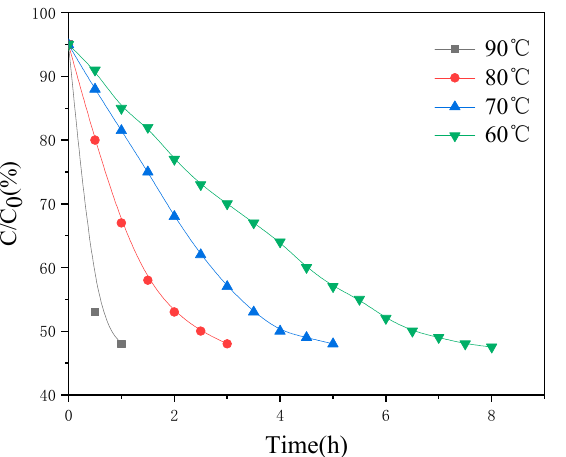
Figure 3. Relationship between -NCO conversion with time and temperature in pre-polymerisation.